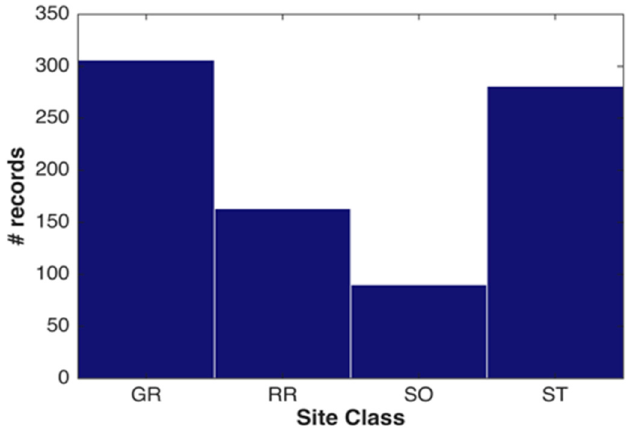
Figure 14. The number of records for each soil class of the GMPEs. GR, generic rock; RR, reference rock; SO, soft soil; ST, stiff soil.